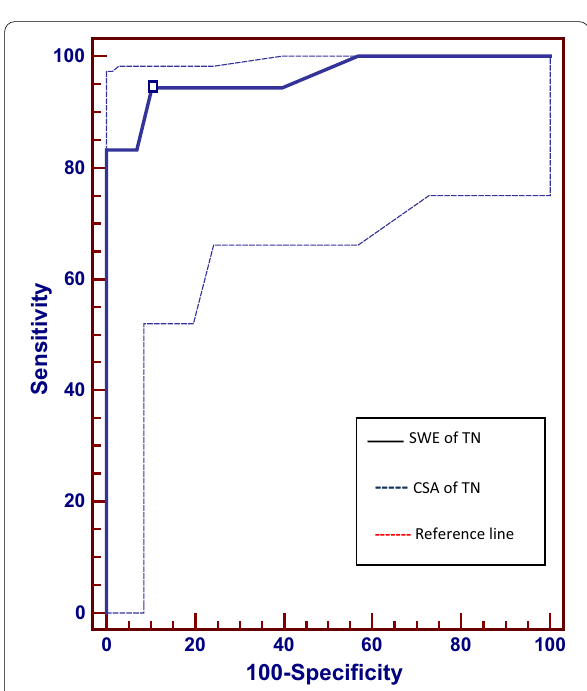
Fig. 8 A Receiver operating characteristic curve analysis showed performance of optimal cut off value for mean stiffness value and CSA of tibial nerve to detect diabetic peripheral